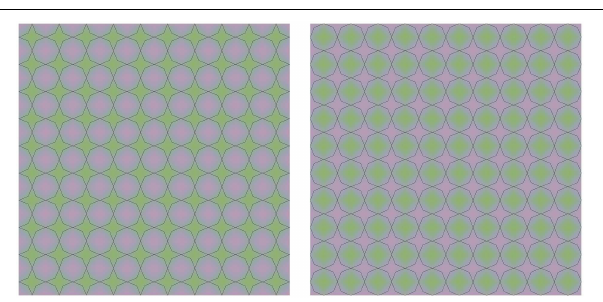
FIGURE 4 | Example of a trial. Two identical color images were presented on the left and the right side of the screen in each individual trial. The superimposed outlines were also identical, but could either be positioned in phase, or in counter phase (as in the example above.) Observers had to indicate if the color appearance in both images was identical or